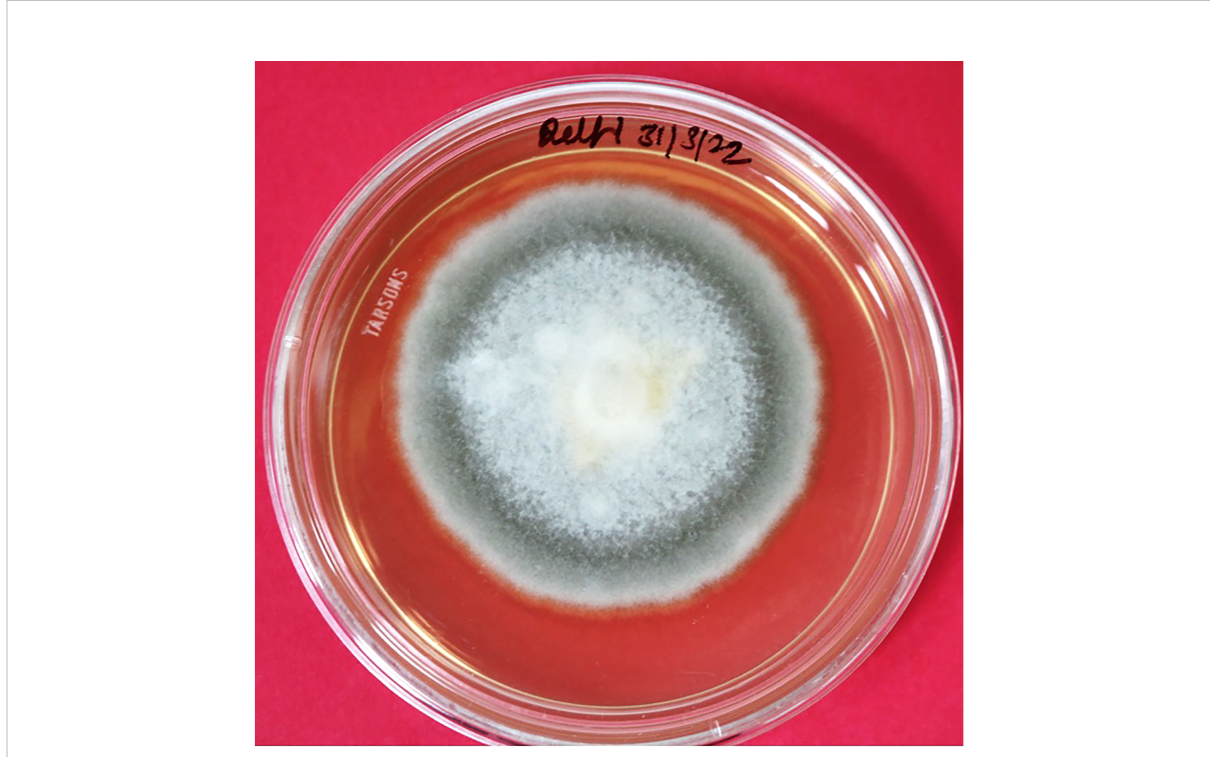
FIGURE 2 Isolation and puri fi cation of Stemphylium vesicarium . Whitish to light gray center, fi liform, whitish margin, and septate mycelia observed on PDA media.